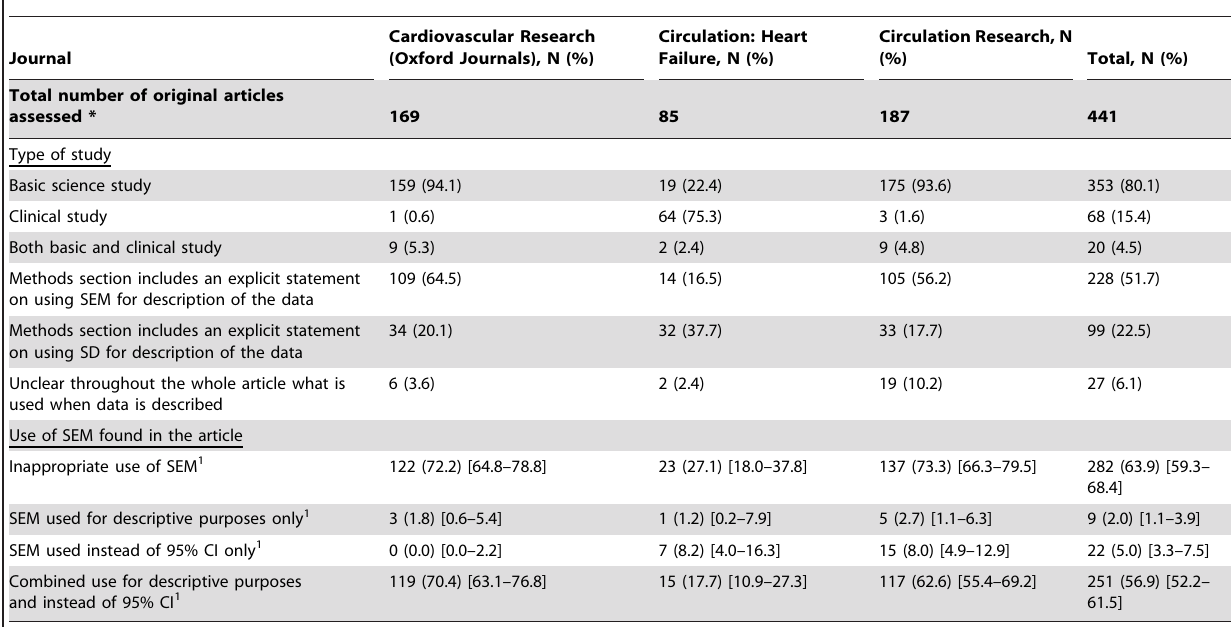
Table 1. Characteristics of articles assessed from three cardiovascular journals edited in the year 2012.